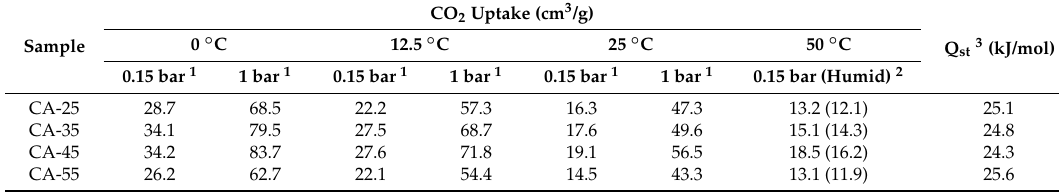
Table 2. CO 2 adsorption capacities of samples under different pressure and operating temperature.